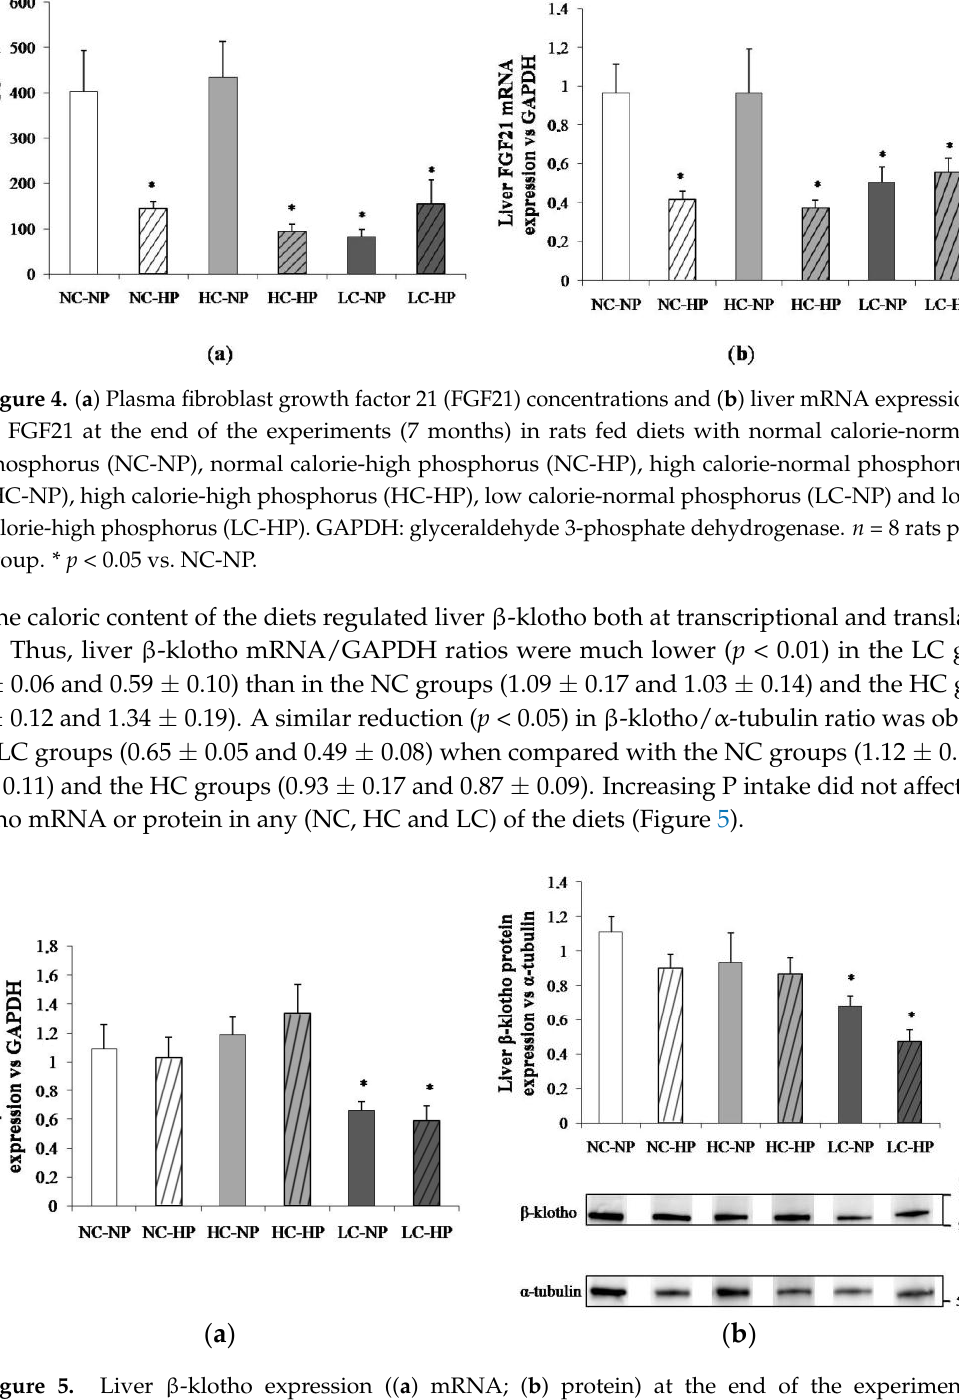
Figure 5. Liver β-klotho expression (( a ) mRNA; ( b ) protein) at the end of the experiments (7 months) in rats fed diets with normal calorie-normal phosphorus (NC-NP), normal calorie-high phosphorus (NC-HP), high calorie-normal phosphorus (HC-NP), high calorie-high phosphorus (HC-HP), low calorie-normal phosphorus (LC-NP) and low calorie-high phosphorus (LC-HP). GAPDH: glyceraldehyde 3-phosphate dehydrogenase. n = 8 rats per group. * p <0.05 vs. NC-NP.